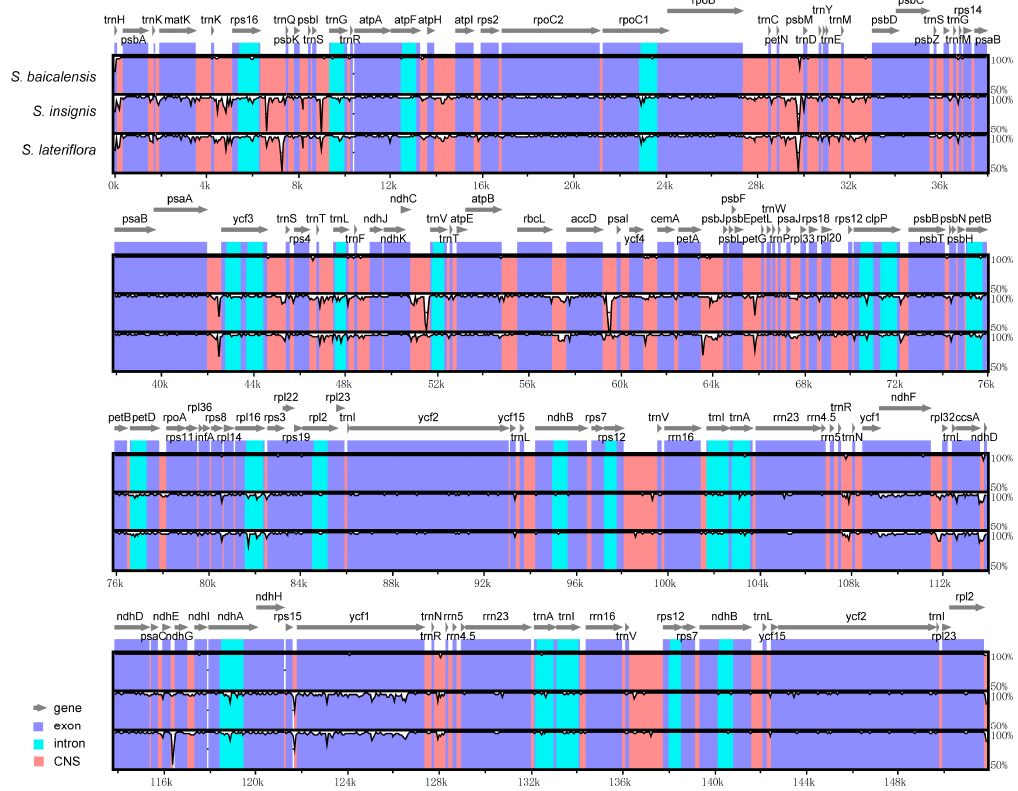
Figure 3. Visualization of the alignment of chloroplast genome sequences of Scutellaria . VISTA-based similarity graphical information illustrating the sequence identity of Scutellaria with reference S. baicalensis chloroplast genomes. Grey arrows above the alignment indicate the orientation of genes. Purple bars represent exons; blue bars represent introns; and pink bars represent non-coding sequences (CNS). A cut-off of 50% identity was used for the plots. The Y-scale axis represents the percent identity within 50–100%. Genome regions are color-coded as protein-coding exons, rRNAs, tRNAs, or conserved CNS.